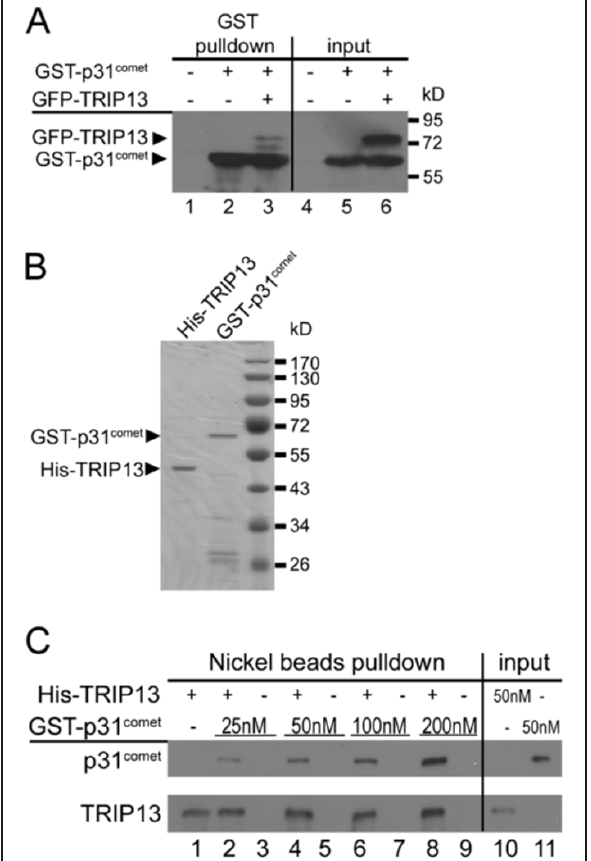
Figure 1 Interaction between TRIP13 and p31 comet . ( A ) GST-p31 comet was expressed either alone or together with GFP-TRIP13 in asynchronous HEK293 cells. The input lysates and GST-pulldowns were probed with anti-GST and GFP antibodies. Untransfected lysates were used as controls. ( B ) Coomassie blue staining of SDS-PAGE gel loaded with ~0.4 μ g of purified recombinant GST-p31 comet and His-tagged TRIP13. ( C ) In vitro binding assays using recombinant His-TRIP13 at 100 nM and GST-p31 comet at increasing concentrations. Proteins associated with washed nickel beads were probed with anti-6×His and anti-GST